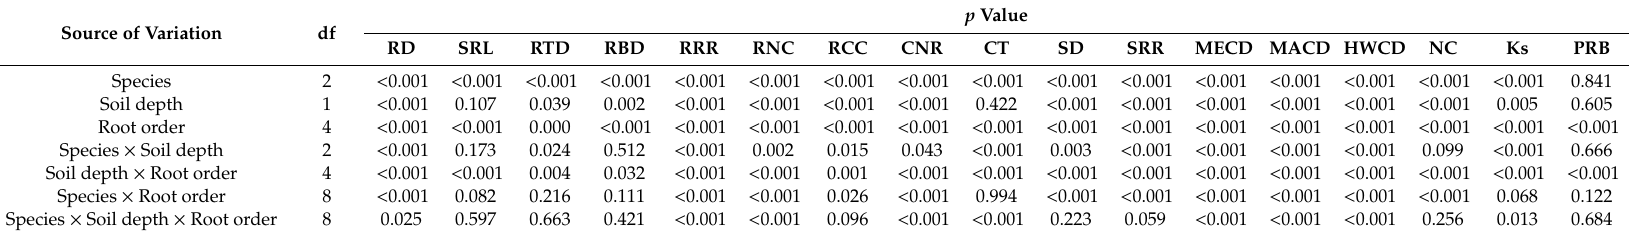
Table 2. Results of a three-way (species × soil depth × root order) factorial ANOVA of root functional